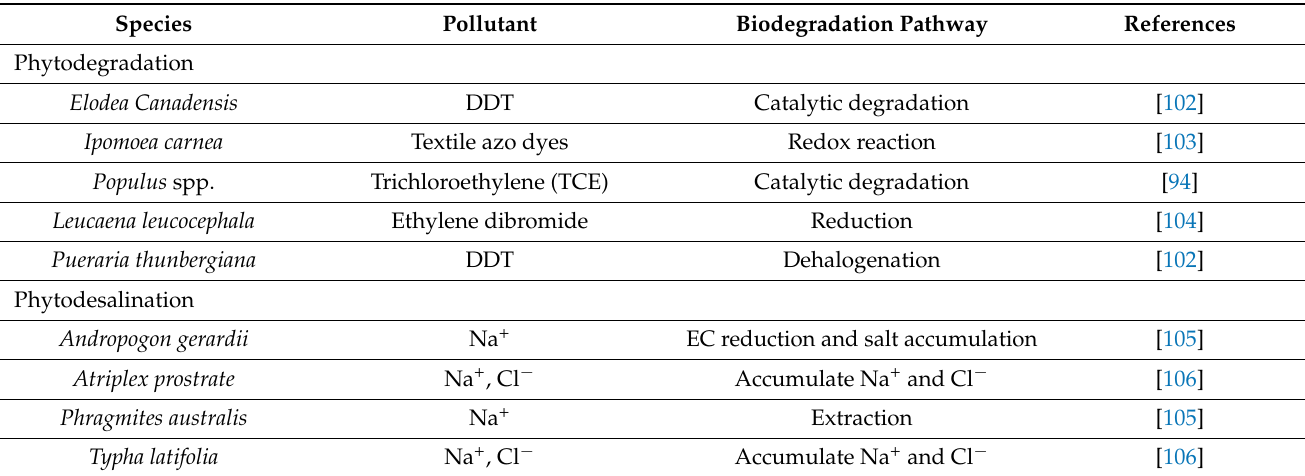
Table 6. Examples of plant species suitable for the phytodegradation and phytodesalination.